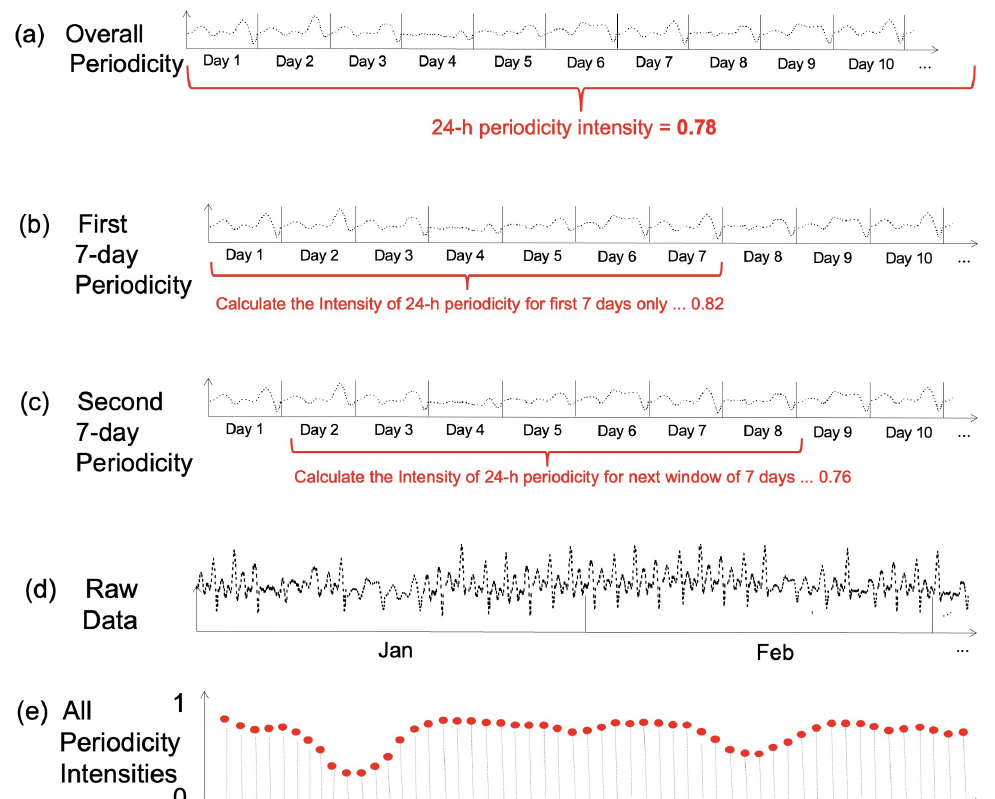
Figure 1. Schematic demonstrating the calculation of periodicity intensity throughout a time series using time-lagged overlapping windows. ( a ) shows overall periodicity for a time series, ( b ) shows periodicity calculated for the first 7 days only, ( c ) shows periodicity for 7 days with a shift of 1 day, ( d ) shows some sample raw data and ( e ) shows periodicity intensity calculated for the whole time